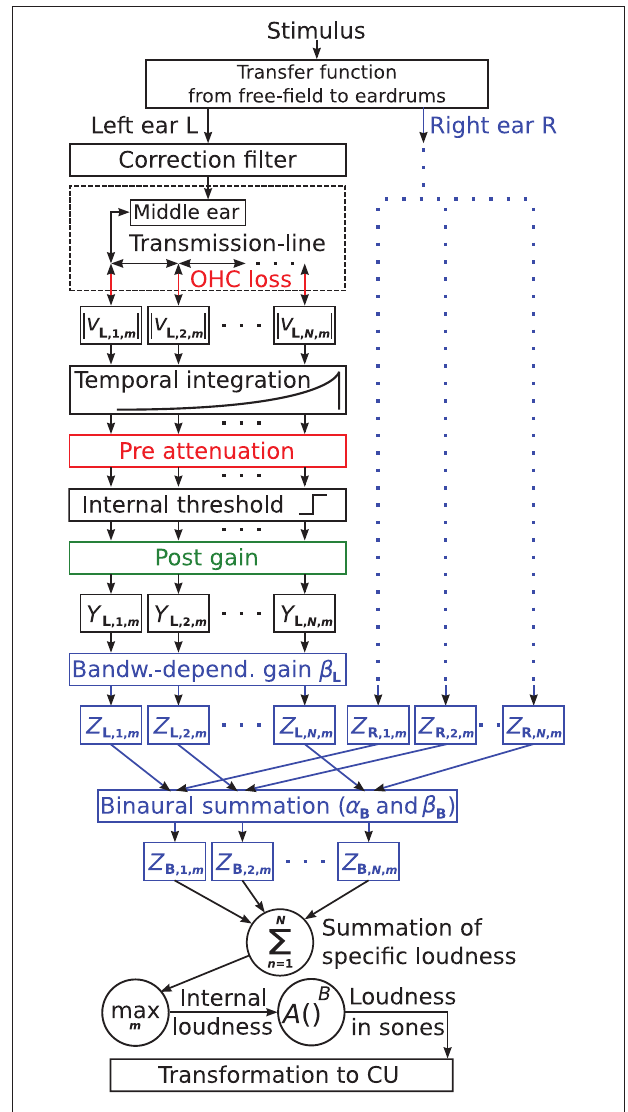
FIGURE 1 | Block diagram of the individual loudness model based on Pieper et al. (2018). Model parts colored in red and green contain frequency-dependent parameters to account for individual hearing loss. Red indicates attenuation and green indicates amplification. Here, the suggested model extensions for further individualization are colored in blue: the parameters β L and β R control a monaural bandwidth-dependent central gain for the left and right ears, respectively. α B controls the overall amount of binaural summation, and β B controls the binaural summation depending on the bandwidth of the input signals Z L , n , m + Z R , n , m